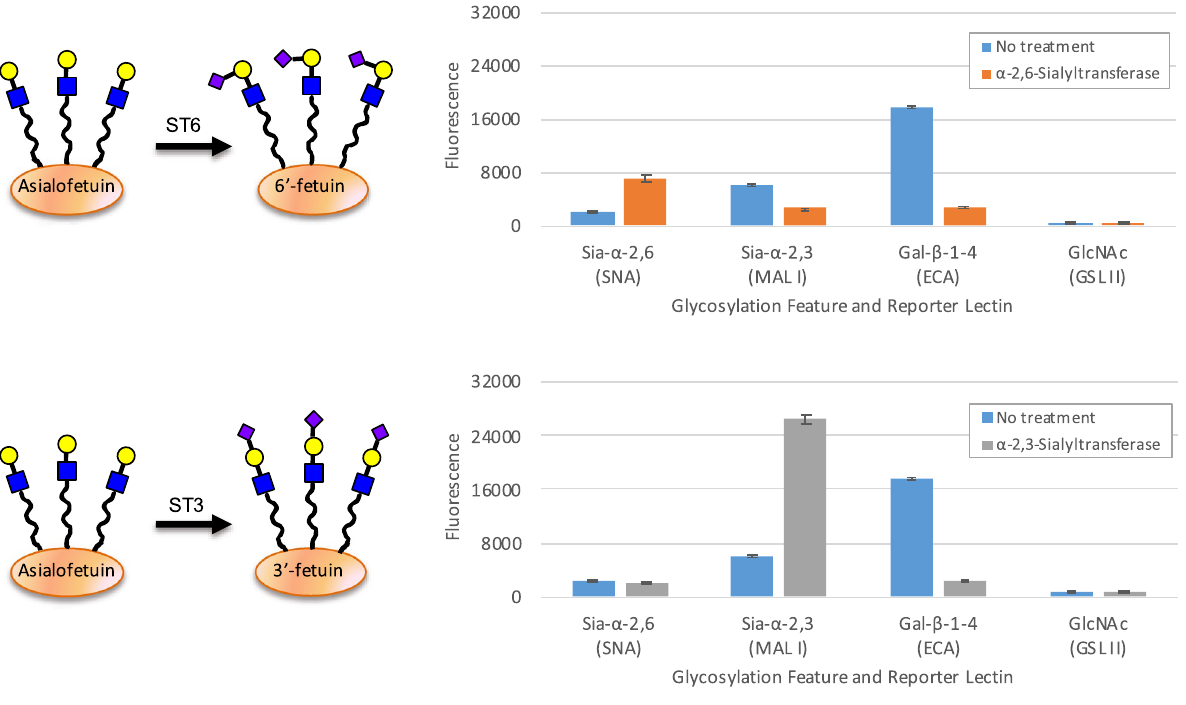
Figure 6. Upper: schematic representation of the glycoengineering of asialofetuin showing the effect of α-2,6- sialyltransferase (ST6) and change in glycosylation features for asialofetuin upon treatment with ST6 (orange) forming Sia-α-2,6-linkages. Lower: schematic representation of the glycoengineering of asialofetuin showing the effect of α-2,3-sialyltransferase (ST3) and change in glycosylation features for asialofetuin upon treatment with ST3 (gray) forming Sia-α-2,3-linkages. BSA background is subtracted. Standard deviations from triplicates are shown as error